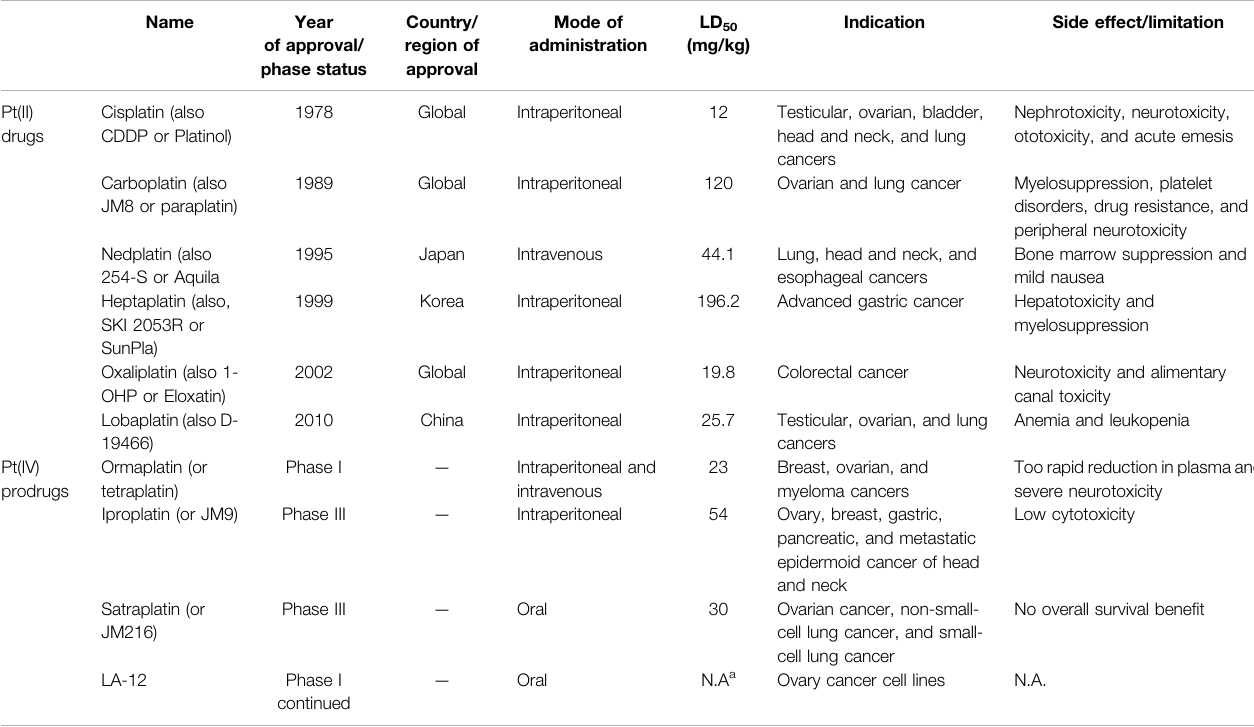
TABLE1| ClinicallyapprovedPt(II)drugs[adaptedfromWheateetal.(2010);Alietal.(2013);Hanetal.(2015);Johnstoneetal.(2016);Imranetal.(2018);Ghosh(2019)]and Pt(IV) prodrugs that have entered clinical trials [adapted from Tutsch et al. (1999); Wheate et al. (2010); Imran et al.